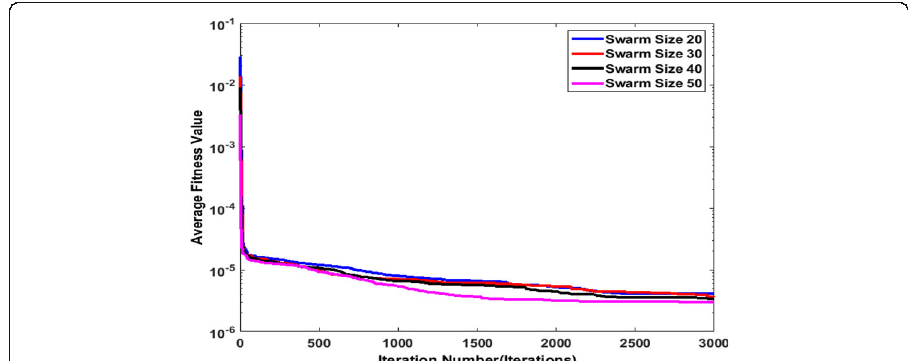
Fig. 6 Convergence speed of QPSO algorithm at different population